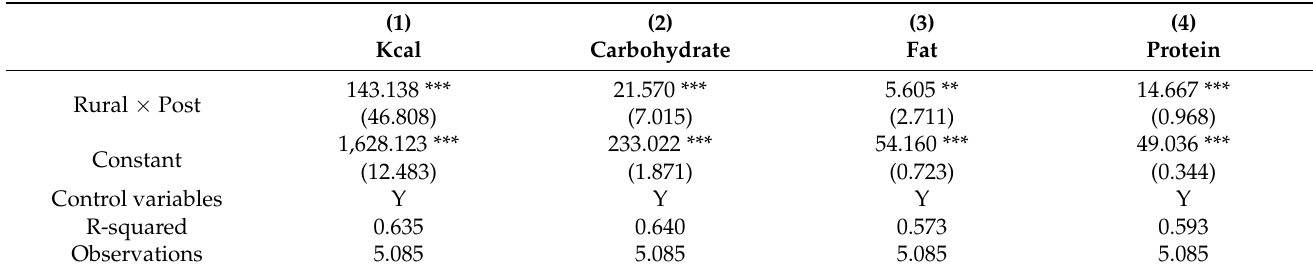
Table 8. Mechanism analysis: the impact of the household technology on nutrition intake.